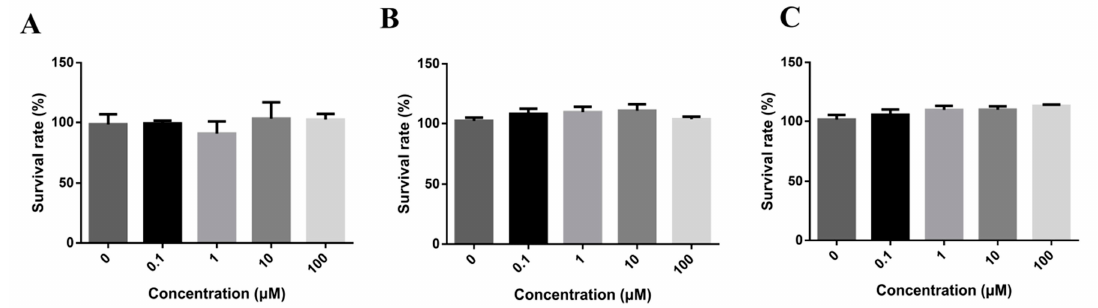
Figure 2. The cytotoxicity of DL0410 on Madi-Darby Canine Kidney (MDCK) cells ( A ) MDCK-MDR1; ( B ) Caco-2; ( C ) DL0410 was tested in a concentration range between 0 and 100 µM for 12 h, using the CCK-8 assay. DL0410 100 µM showed non-toxicity after 12 h. (Mean ± SD, n = 3).